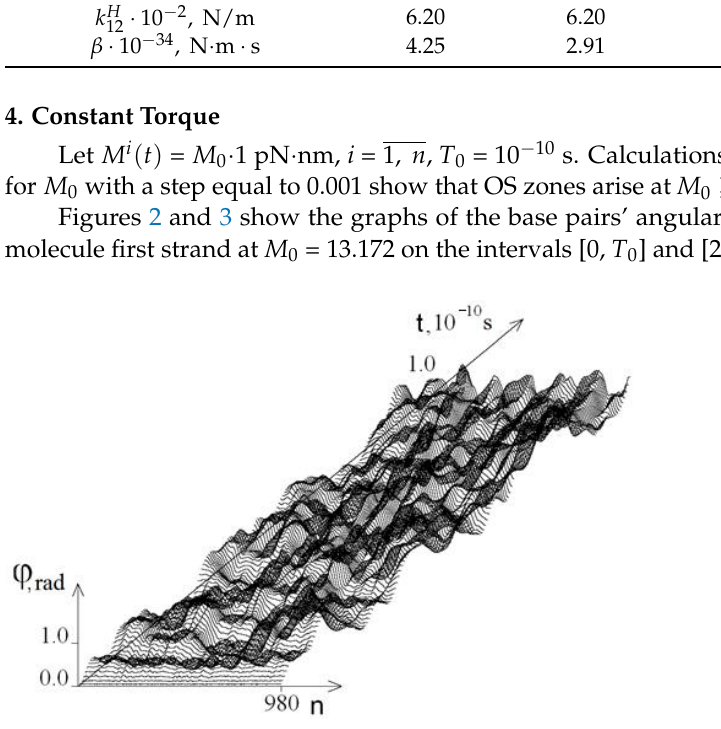
Figure 2. Graphs of angular deviations of the first strand of the DNA molecule at M 0 = 13.172 on the time interval [0, T 0 ].